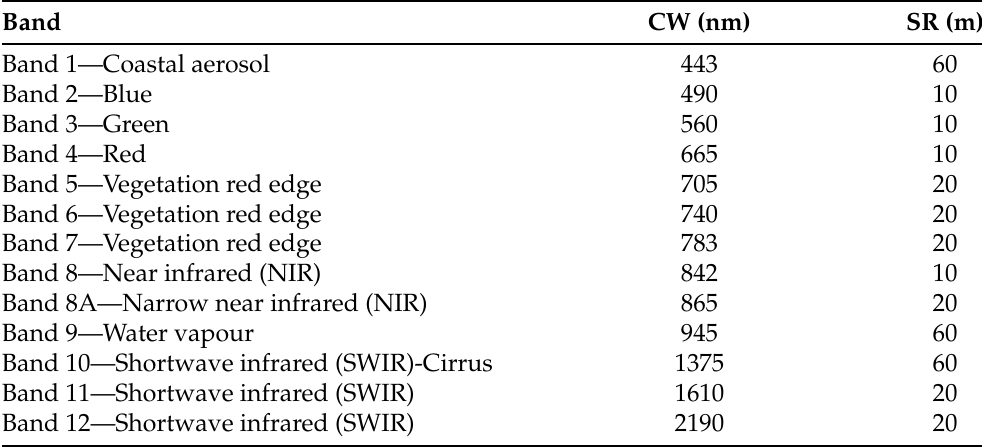
Table 1. Description of Sentinel-2A satellite image providing band details, corresponding Central Wavelength in (nm) and Spatial Resolution (m) in three columns,